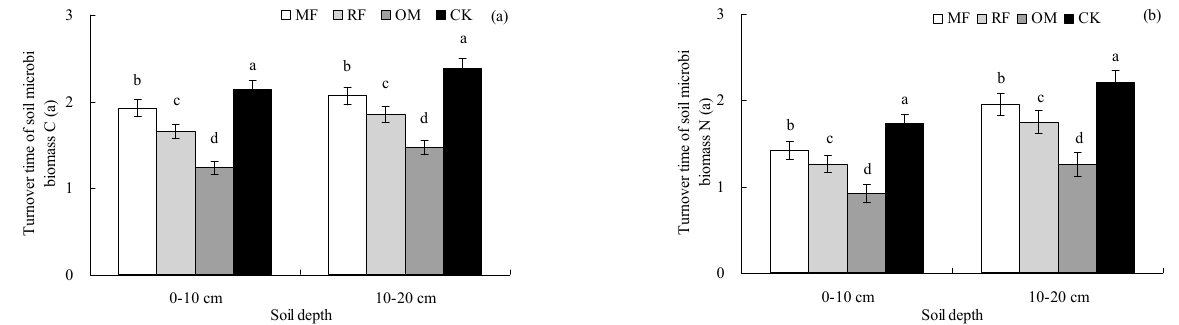
Figure 4. Effects of different long-term fertilizer treatments on flux turnover time of soil microbial biomass carbon ( a ) and nitrogen ( b ) in the double-cropping rice field. Different lowercase letters indicate significant differences ( p < 0.05) among different fertilizer treatments.